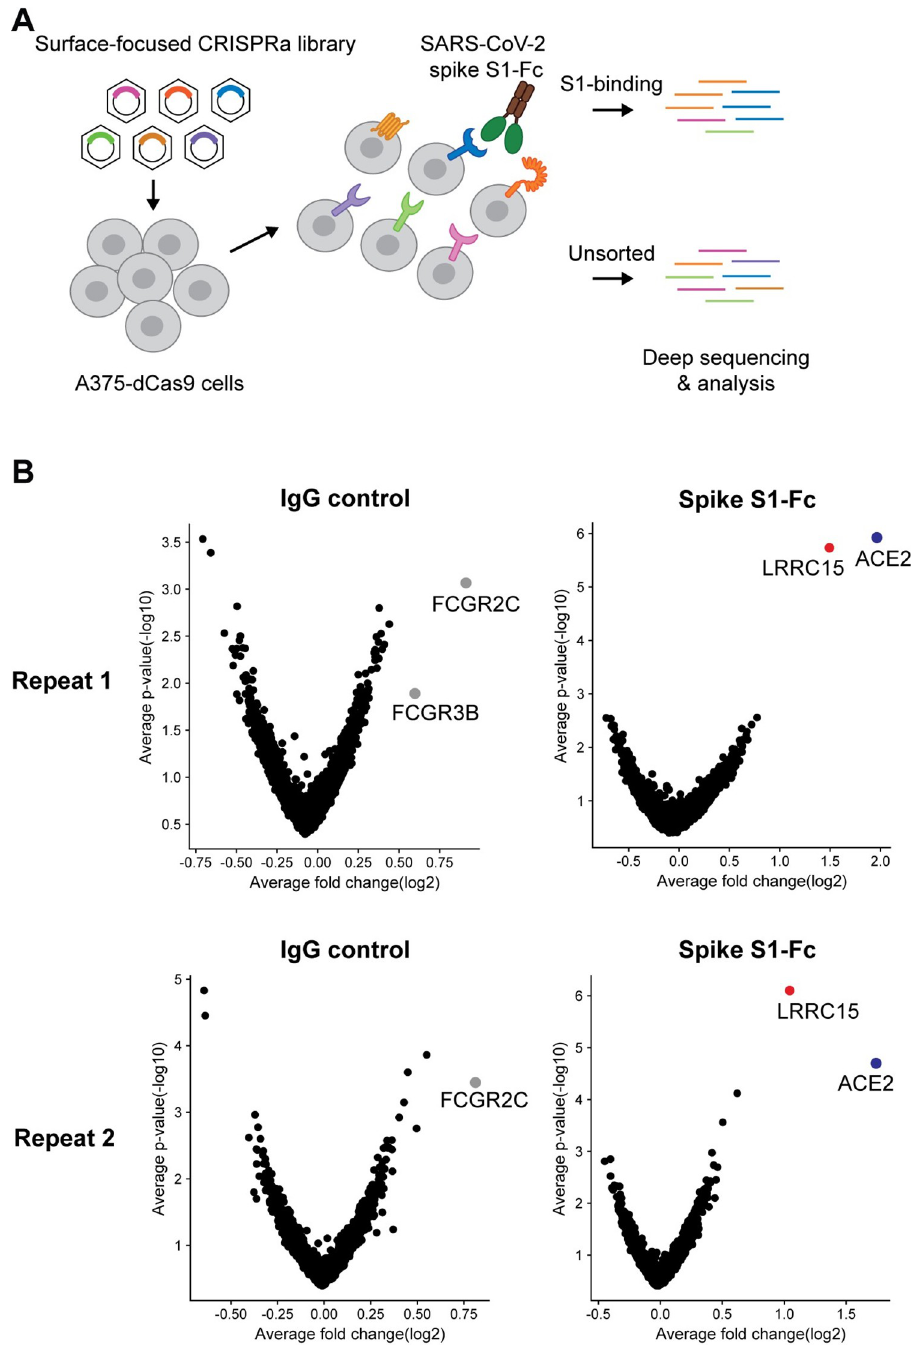
Fig 1. A surface ome-focused CRISPRa screen identified cellular receptors binding with SARS-CoV-2 spike protein. ( A ) Schematic of a focused CRISPRa screen for surface proteins interacting with SARS-CoV-2 spike S1-Fc fusion protein. ( B ) Volcano plots showing sgRNAs enriched or depleted in cells binding with SARS-CoV-2 spike S1-Fc or human IgG isotype control. Results from 2 biologically independent replicates are shown. For underlying data, see S1 Data . ACE2 AU : AbbreviationlistshavebeencompiledforthoseusedinFigs 1 (cid:0) 6 : Pleaseverifythatallentriesarecorrect : , angiotensin-converting enzyme 2; CRISPRa, CRISPR activation; dCas9, “dead” Cas9; IgG, immunoglobulin G; LRRC15, leucin-rich repeat-containing 15; SARS-CoV-2, Severe Acute Respiratory Syndrome Coronavirus 2; sgRNA, single guide